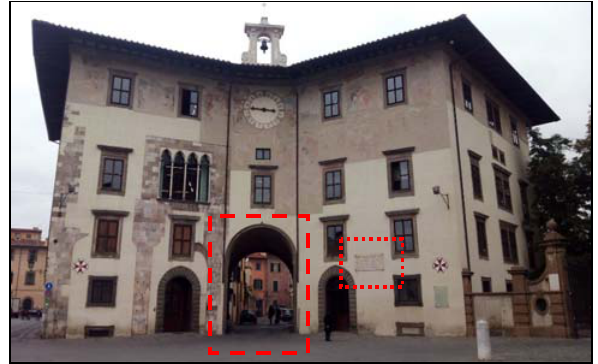
Figure 2 – Actual view of the “Palazzo dell’Orologio” building at Pisa (Italy) with the arch location on the main façade (discontinuous red line) in Piazza Cavalieri.